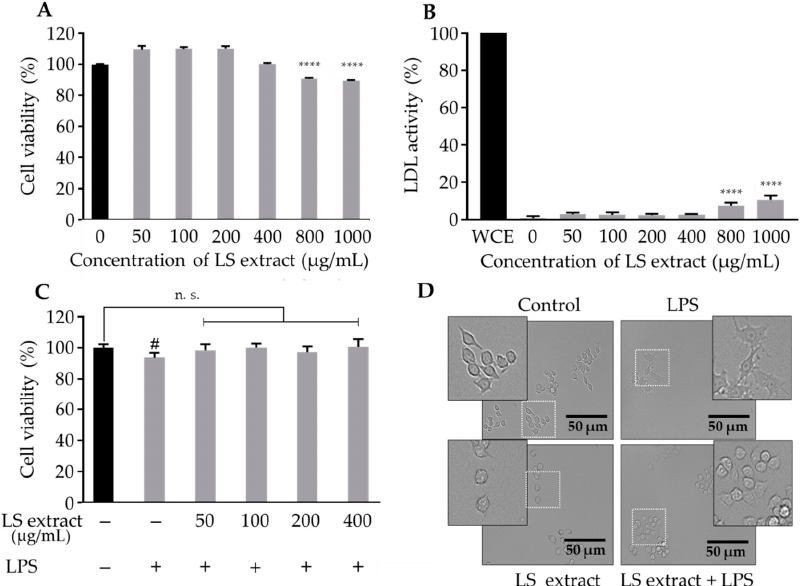
Figure 2. Effects of LS leaf extract on cell viability and morphology of RAW 264.7 cells. RAW 264.7 macrophages were cultured with LS leaf extract for 24 h, and then cell viability based on intracellular dehydrogenase activity ( A ) and cytotoxicity based on lactate dehydrogenase (LDH) activity released in culture medium ( B ) were measured. Whole-cell extract (WCE) was prepared as a positive control representing 100% activity in ( B ). After pretreatment with LS extract for 24 h, RAW 264.7 cells were stimulated by LPS (1 μ g/mL) for 18 h, and then cell viability was measured ( C ). RAW 264.7 cells were treated with medium only (control), LPS, or LS extract (400 μ g/mL) for 24 h. The LS extract + LPS group was treated with LPS (1 μ g/mL) for 18 h. Cell morphology was observed under a phase-contrast microscope ( D ). Magnification of the region framed with a dotted white line is shown in the frame with a black line. Values represent the mean ± SD ( n = 6). Statistical significance was calculated by t - test and one-way ANOVA. Scale bar in ( D ), 50 μ m; # p < 0.05; **** p < 0.0001 vs. cells treated with media only; n. s., not significant.